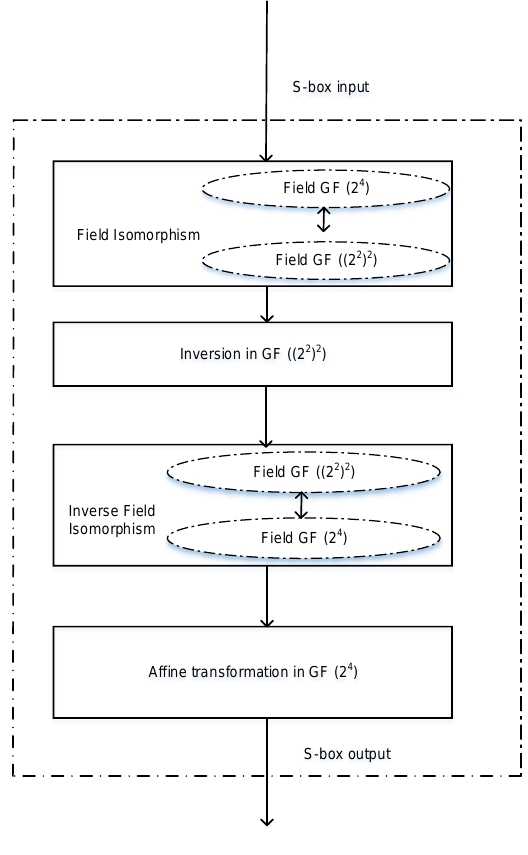
Figure 1. Design methodology.